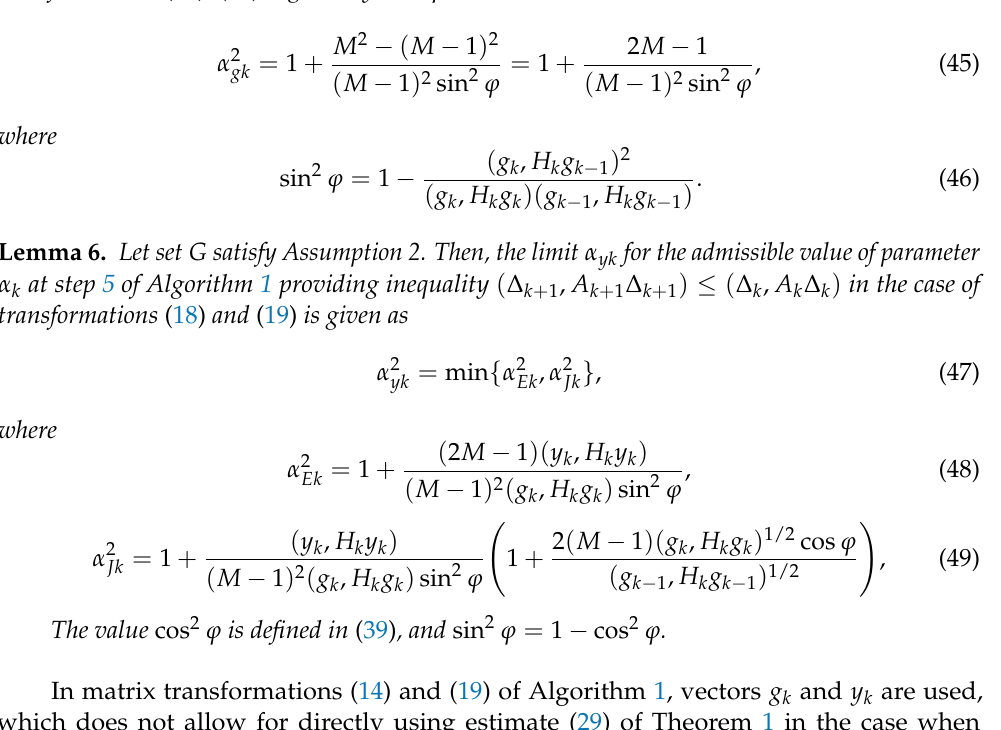
= α 2 specified at steps 5 and 6, k